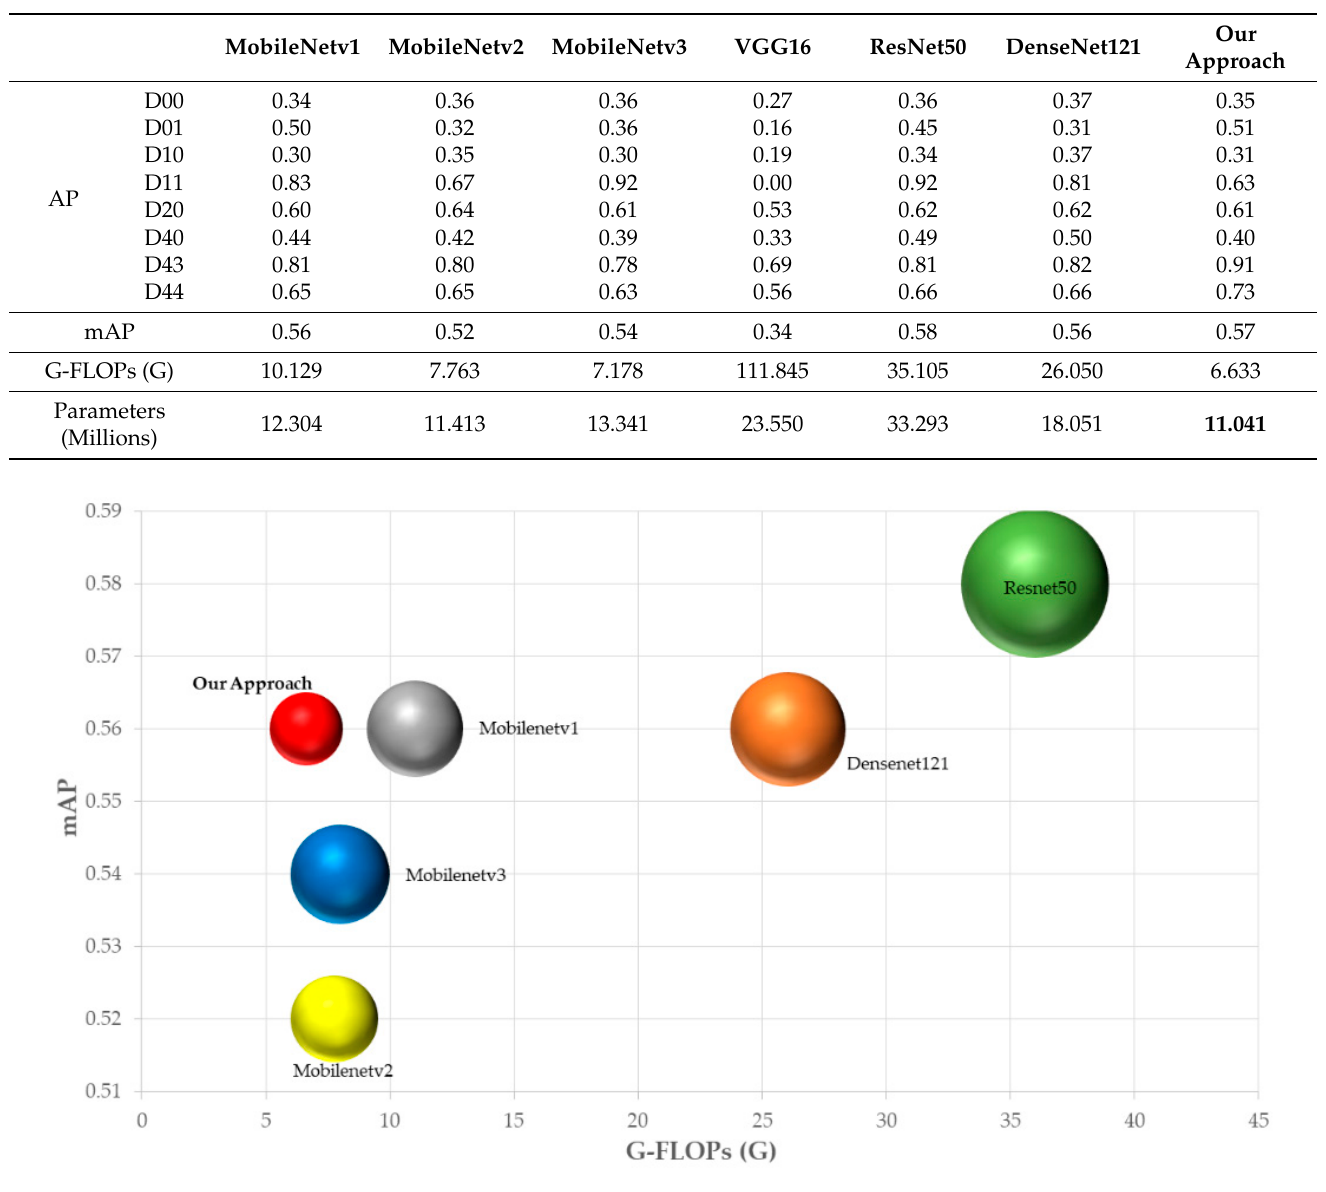
Figure 9. G-FLOPs vs. mAP. Details are in Table 9.